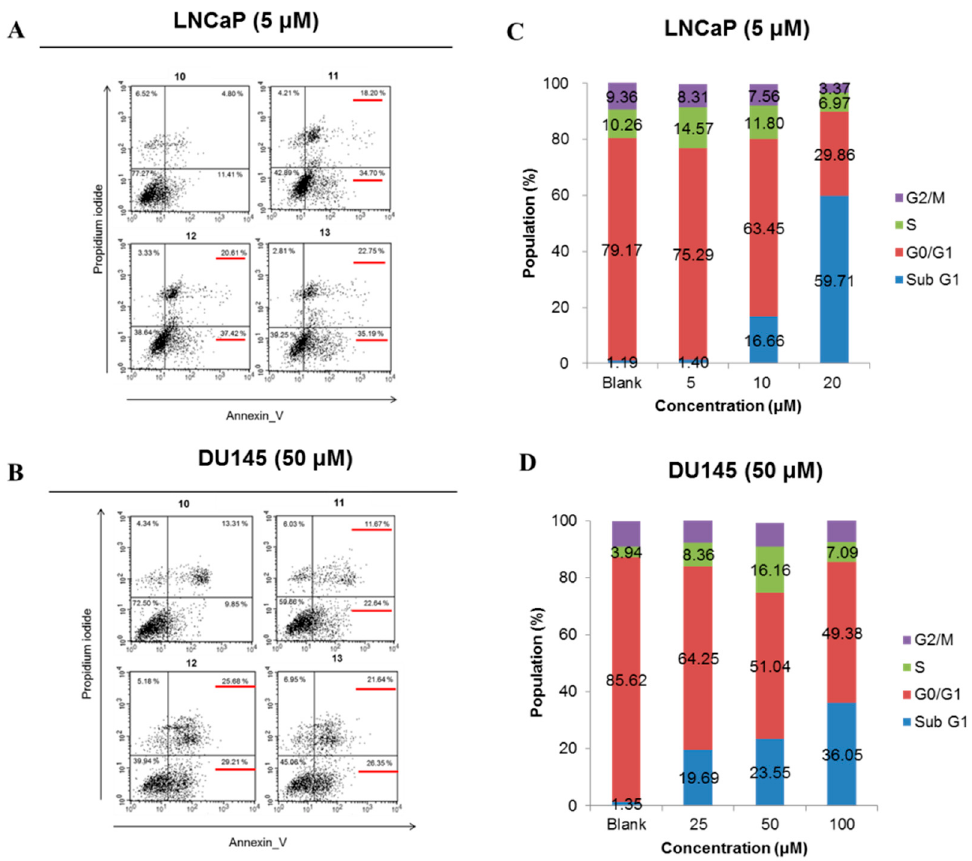
Figure 3. Induction of apoptosis ( A , B ) and cell cycle arrest ( C , D ) by dimeric ellagitannins ( 11 – 13 ) from C. alba . The apoptosis induction and cell cycle distribution were analyzed on flow cytometry. Concentrations of 5 or 50 µ M of each compound were used to treat LNCaP and DU145 cells for 48 h, respectively. In A and B, the percentages of cells in each quadrant are indicated as follows—lower left: normal, lower right: early apoptosis, upper right: late apoptosis, upper left: necrosis.